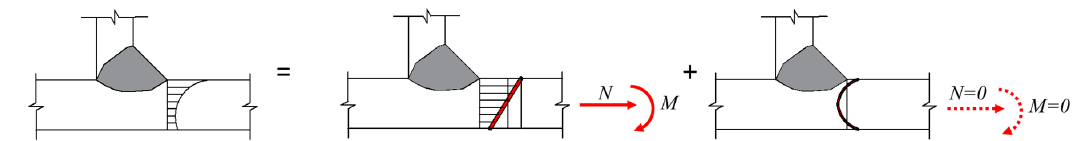
Figure 1. The decomposition of the inner force at the plane of weld toe.